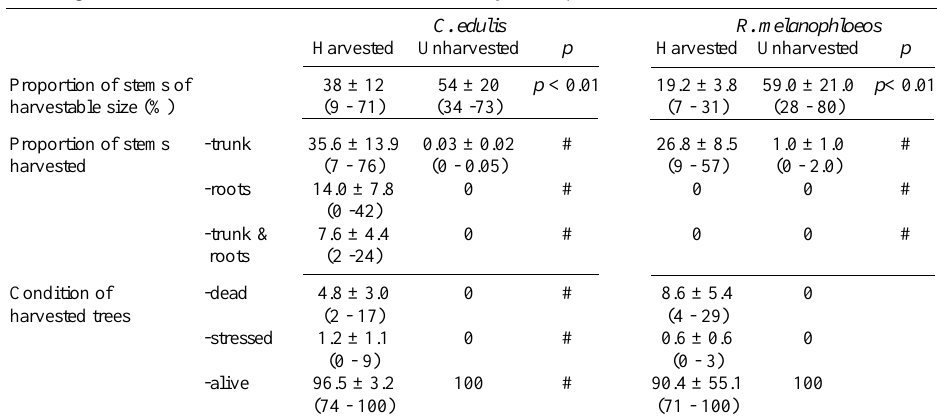
Extent of harvesting of Catha edulis and Rapanea melanophloeos populations (Mean ± SE ) and condition of the harvested stems. (Range in brackets under the mean) (# statistical analysis not performed as n = 0 in one or more